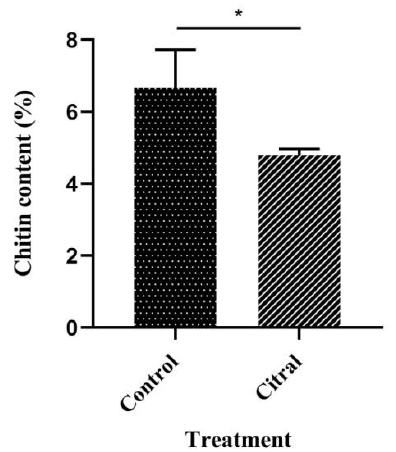
Figure 3. Citral decreases chitin content of R. flaviceps workers. Mean (±SD) values with * show significant difference ( p < 0.01), according to Tukey’s HSD test.